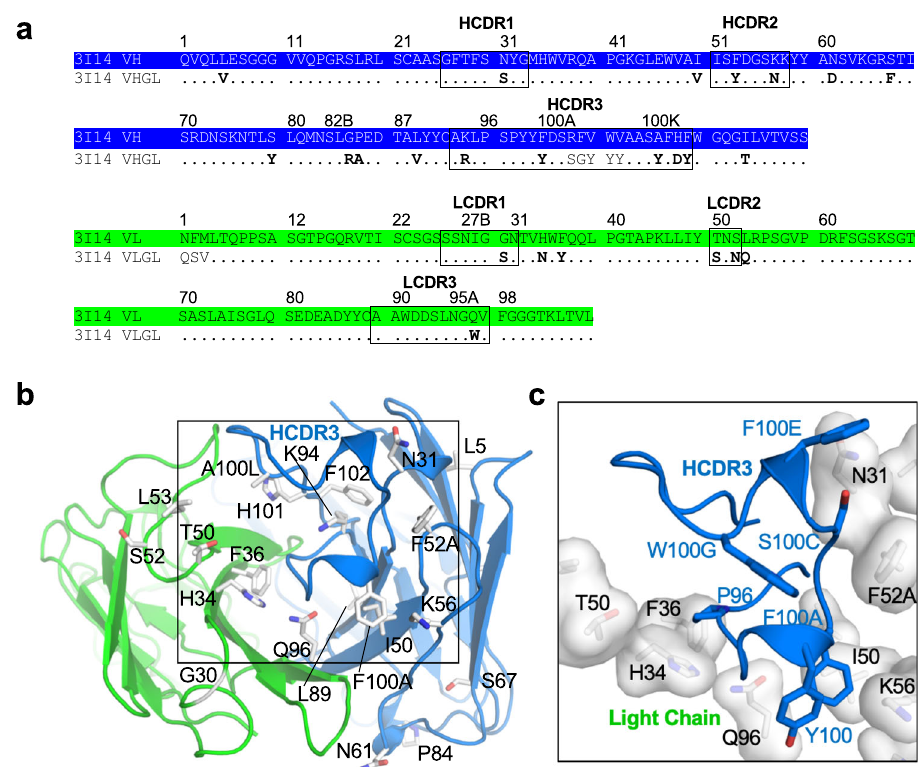
Fig. 3 3I14 Somatic hypermutations shape HCDR3. a Sequences for 3I14 heavy- and light-chain wild type and germline. Somatic hypermutations (SHMs) are in bold. b SHMs on the 3I14 heavy and light chains are shown as white sticks and labeled. c Zoomed in box from b showing the SHMs that surround the HCDR3 as white transparent surfaces and sticks. HCDR3 is shown as a cartoon and sticks. The HCDR3 is shaped by interactions with the SHMs, which surround